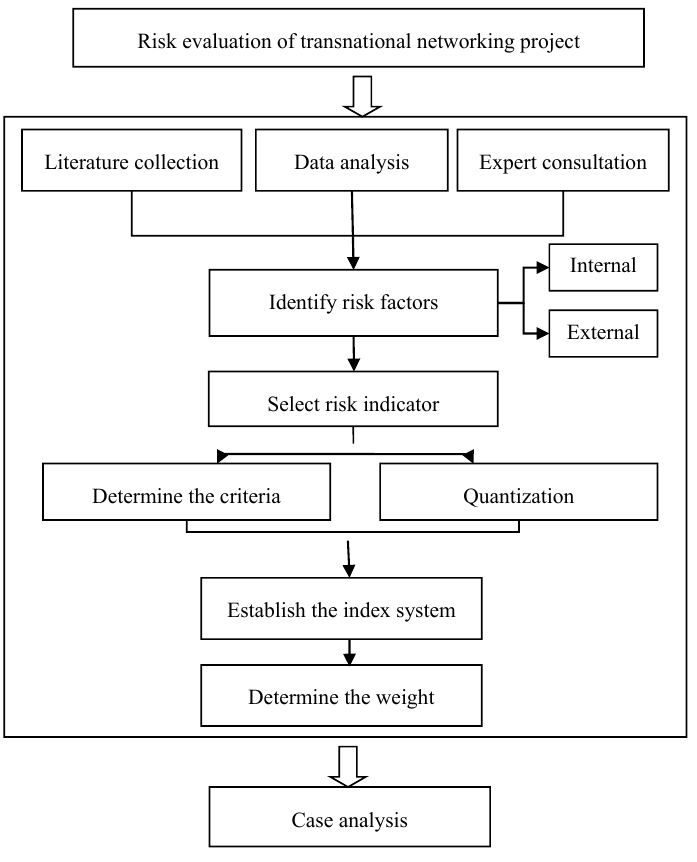
Figure 1. Research procedure.